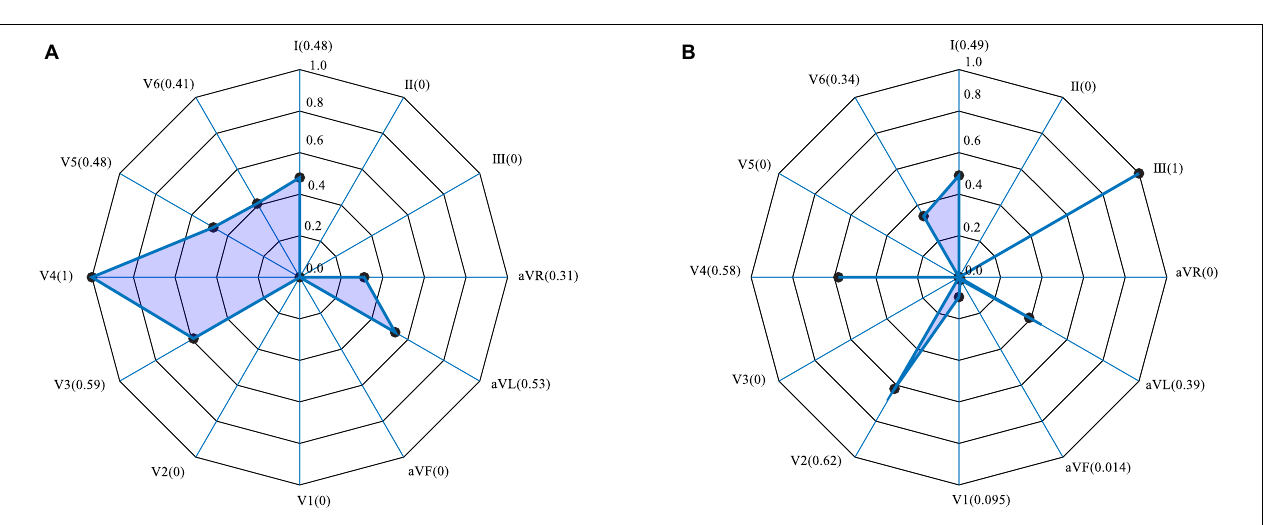
FIGURE 6 | 12-lead ECG weightings obtained by SENet. Polar plots from two representative infarctions. (A–G) Anterior MI: (A) without convolution; (C) with 3 × 1 convolution; (E) with 5 × 1 convolution; (G) with 7 × 1 convolution. (B–H) Inferior MI: (B) without convolution; (D) with 3 × 1 convolution; (F) with 7 × 1 convolution; (H) with 7 × 1 convolution.